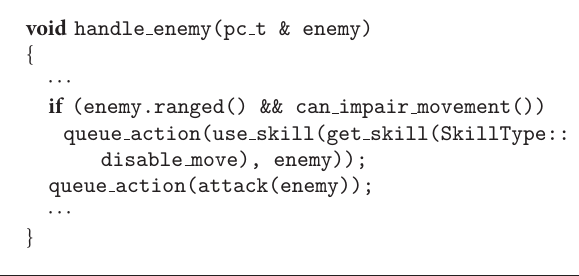
Algorithm 2: Conceptual combat code snippet.